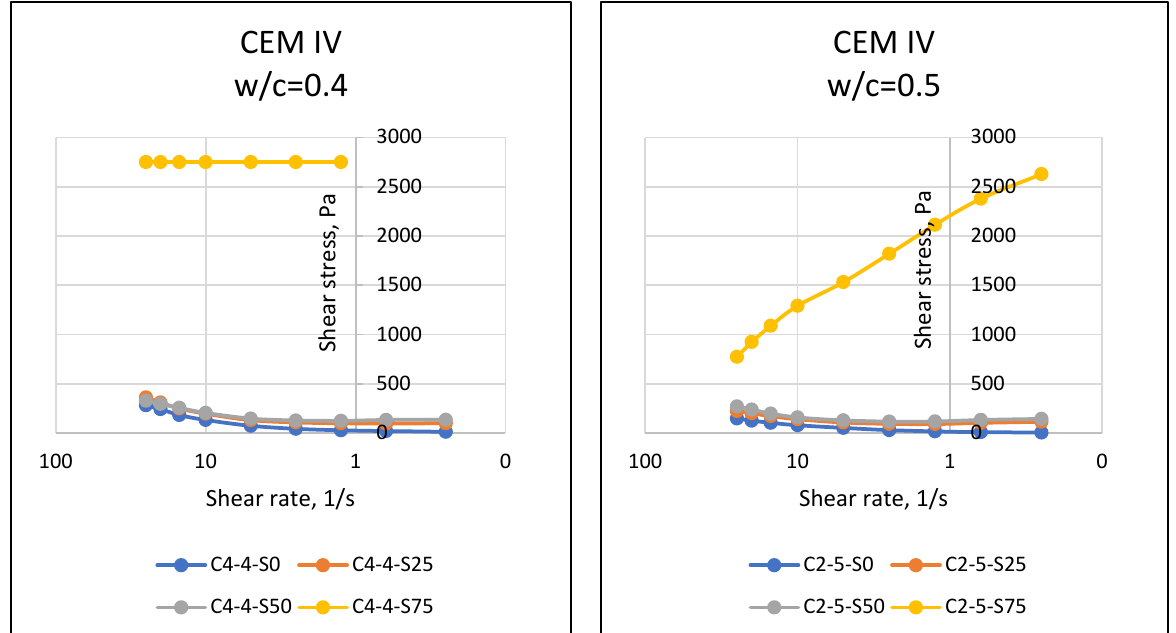
Figure 7. Shear Stress–Shear Rate Relationships of SAPCPs with CEM IV (w/c = 0.40 and 0.50).